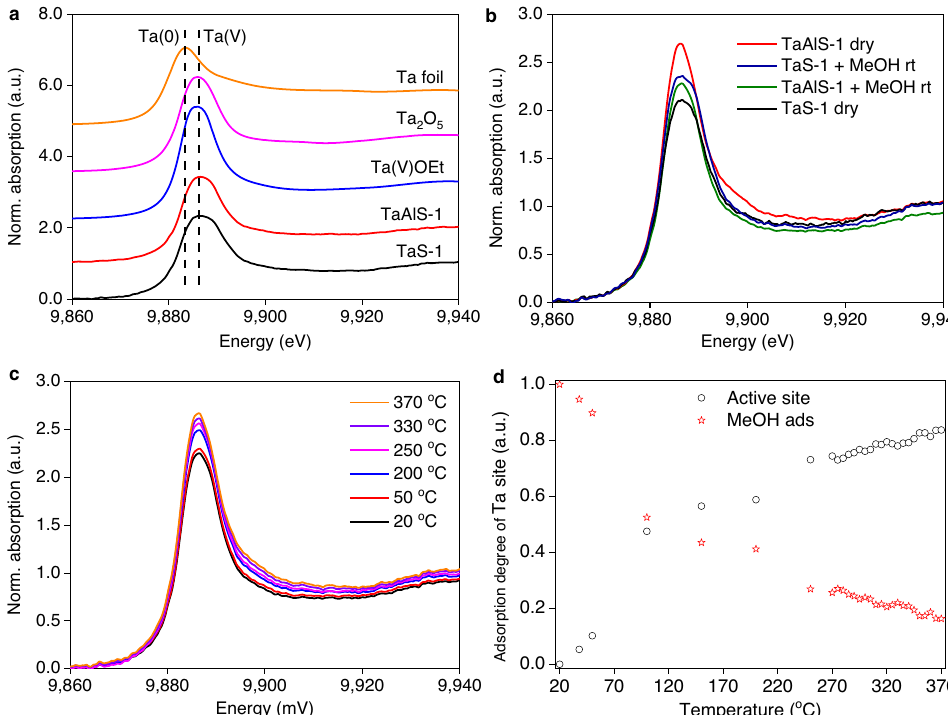
Fig. 4 Ta L 3 -edge X-ray absorption spectroscopy (XAS) for TaAlS-1 zeolite and references. a XANES spectra at the Ta L 3 edge of Ta foil, Ta(V) references and Ta-zeolites. b XANES spectra illustrating the in fl uence of methanol adsorption at room temperature on Ta-zeolites. c Operando XANES spectra at the Ta L 3 edge of TaAlS-1 zeolite during the conversion of methanol, only selected spectra shown. d Deconvolution of XANES via linear combination fi tting to activated and adsorbed